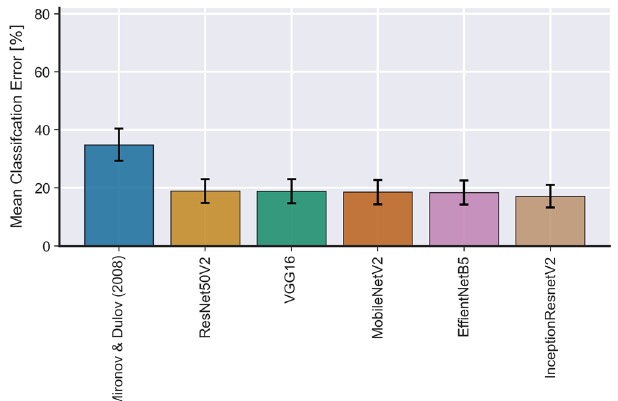
Figure 4. Comparison between averaged classification error for active wave breaking detection between Mironov and Dulov’s (2008) 30 method and all the neural network architectures implemented here. The error bars represent one standard deviation from the mean. The data used for this comparison are from the 2013 Black Sea experiments described in Table